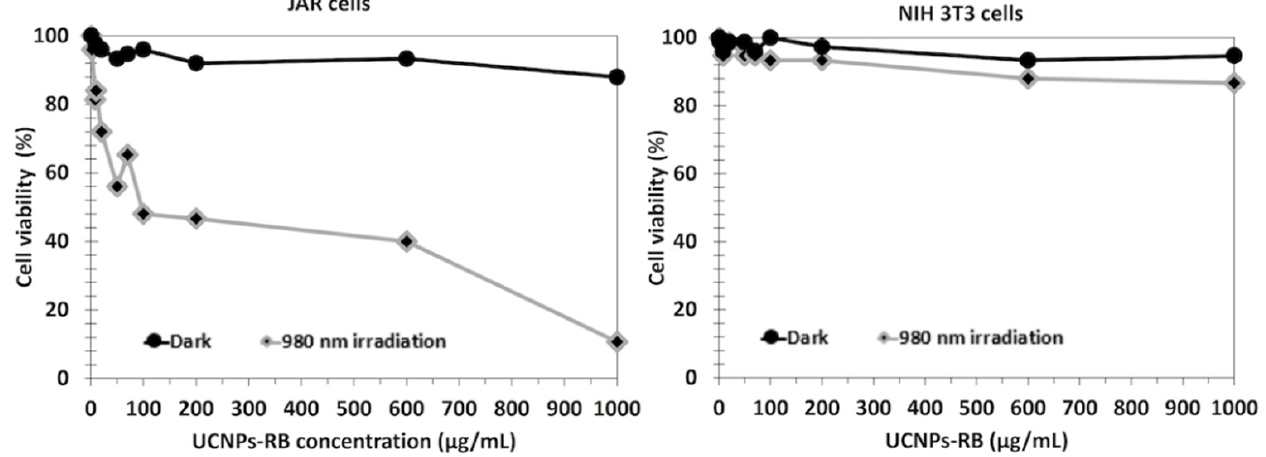
Figure 2. JAR and NIH 3T3 cells viability in dark and after excitation at 980 nm (1.5 W/cm 2 , 10 min) with increasing UCNPs-RB concentration. Adapted from Liu et al. [20].